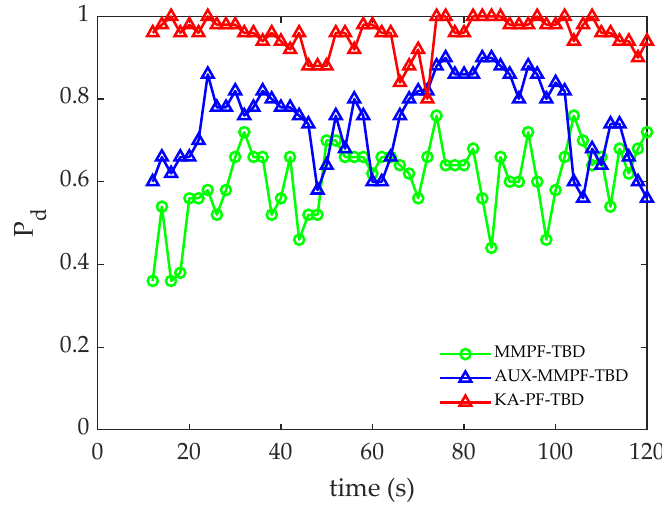
Figure 9. The accurate detection of probability sequences.